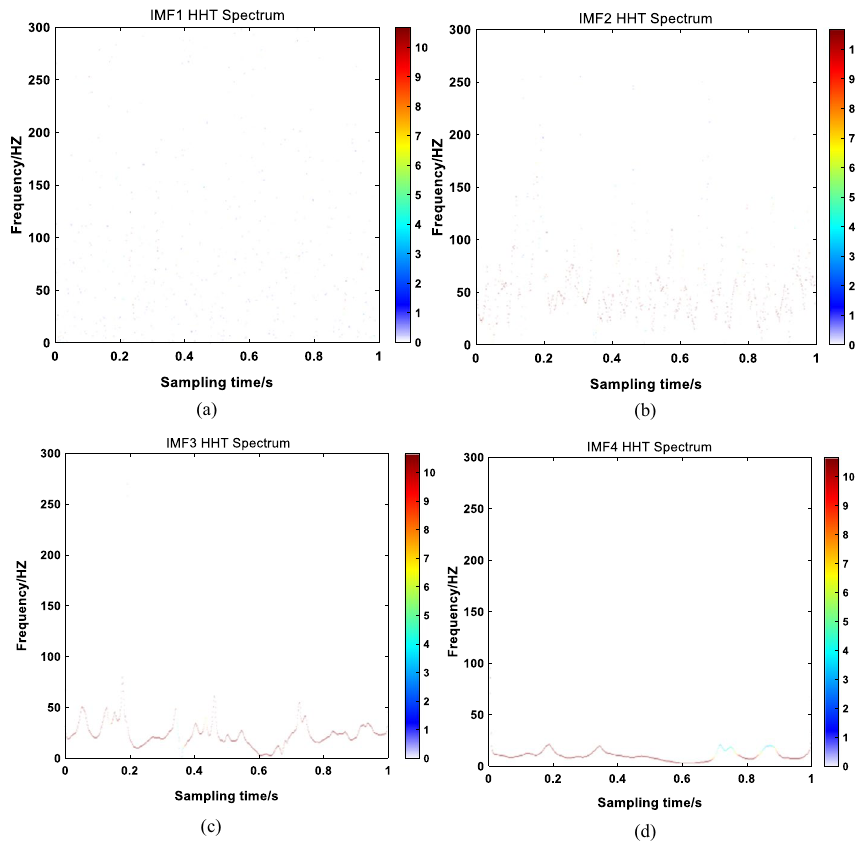
Fig. 17 IMF1–IMF4 HHT